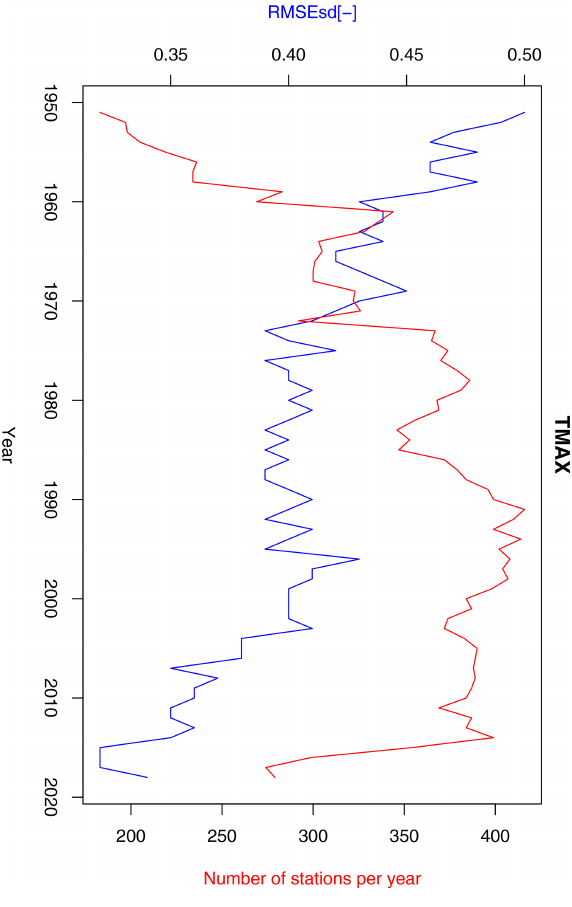
Figure 14. Annual RMSEsd median (blue) and number of avail- able stations per year (red) for maximum temperature in the period 1951–2019. The daily results, also summarized in Table 1, were used for calculating the annual medians.